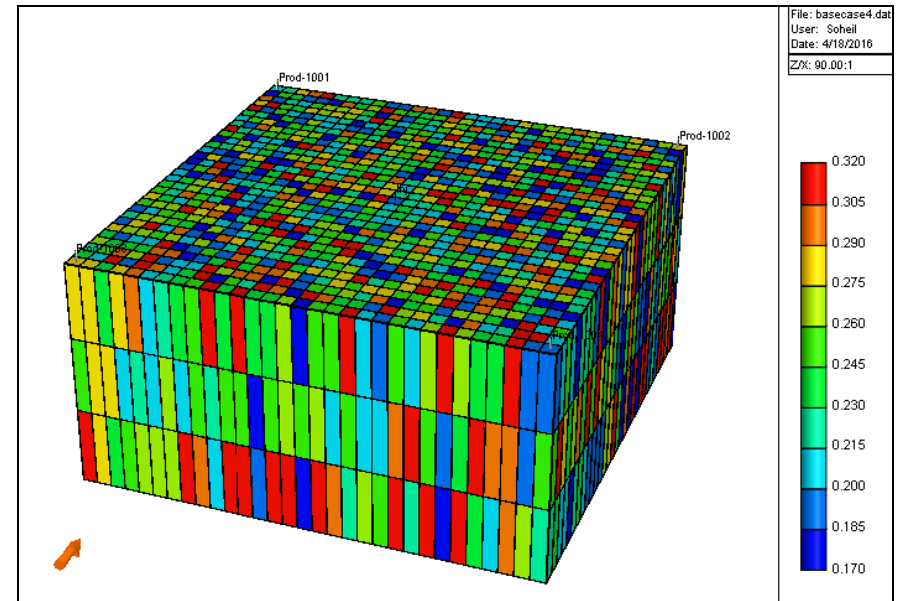
Figure 2. Base model of the reservoir with average porosity of 25%